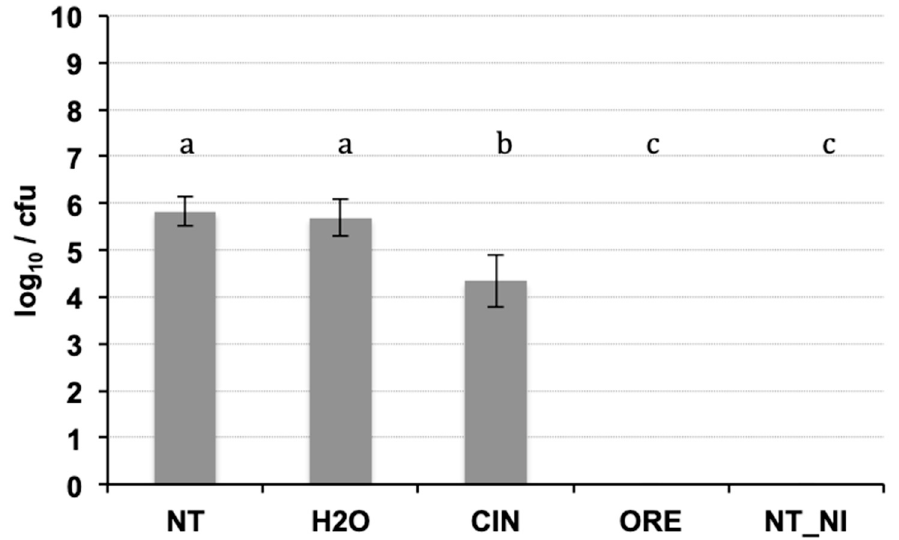
Figure 3. Quantification of pest biomass in plant: standard curves obtained on gDNA from 10-fold serial dilutions of ( a ) Cmm and ( b ) Rs suspensions (colony forming units (CFU) / mL) in presence of plant DNA to relate the cycle threshold (Ct) value to bacterial load (CFU / mL).